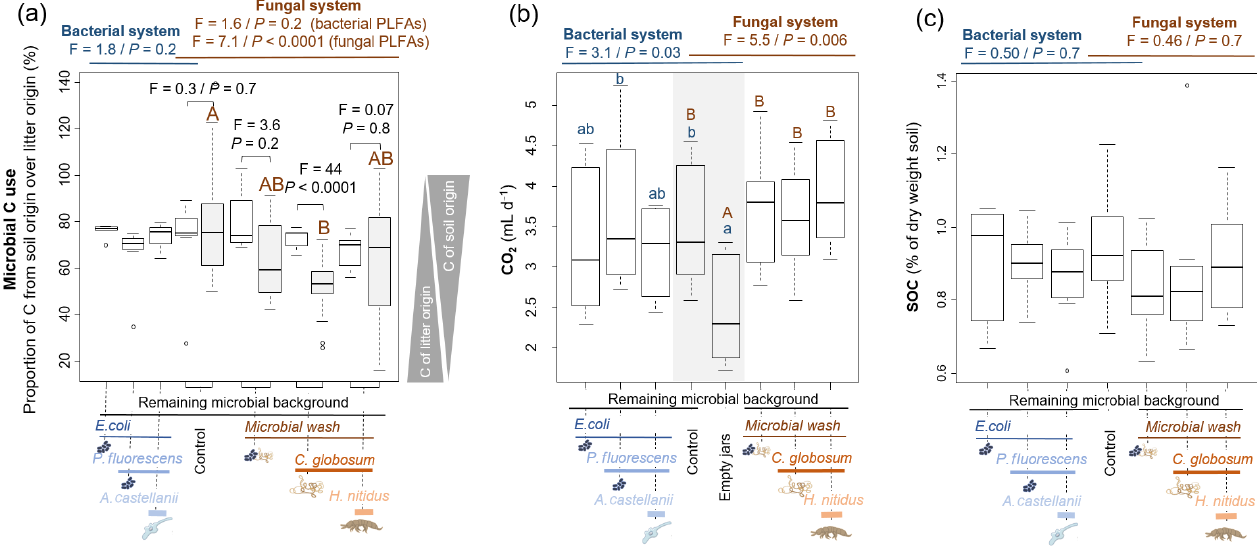
Figure 3. Effect of bacterial and fungal consumer–prey inoculations on C dynamics. (a) Microbial C use, indicated by the relative contri- bution of C from soil over litter in bacterial and fungal PLFA markers. Grey boxes indicate fungal PLFAs. (b) CO 2 production from soil microorganisms and animals; data are average emissions over 48h after 4 and 6 weeks of incubation. Grey background indicates control treatment of both the bacterial and fungal system. (c) SOC concentrations. Differences between treatments were analysed separately for the bacterial and fungal systems using GLS models followed by ANOVA and post hoc Tukey tests. Letters (blue lowercase for bacterial system and brown capital for fungal system) indicate significant differences between means. In addition, in panel (a) , for the four treatments of the fungal system, the differences in C origin in bacterial and fungal PLFAs were tested (pairwise